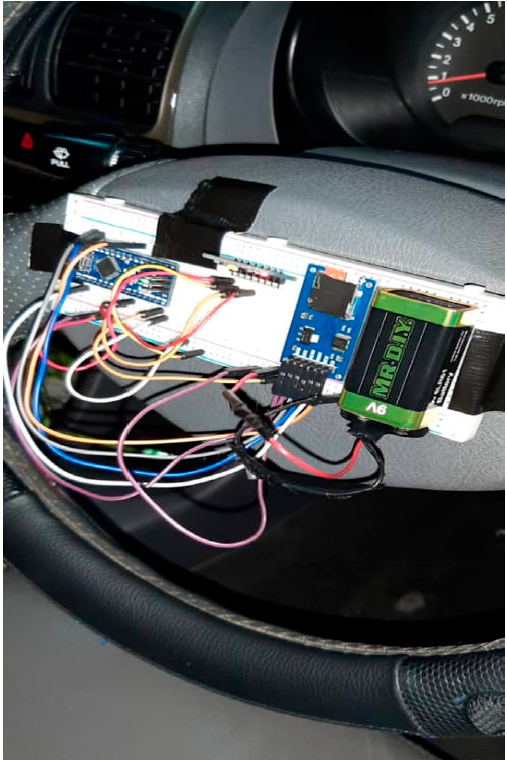
Figure 5. Early IMU design.